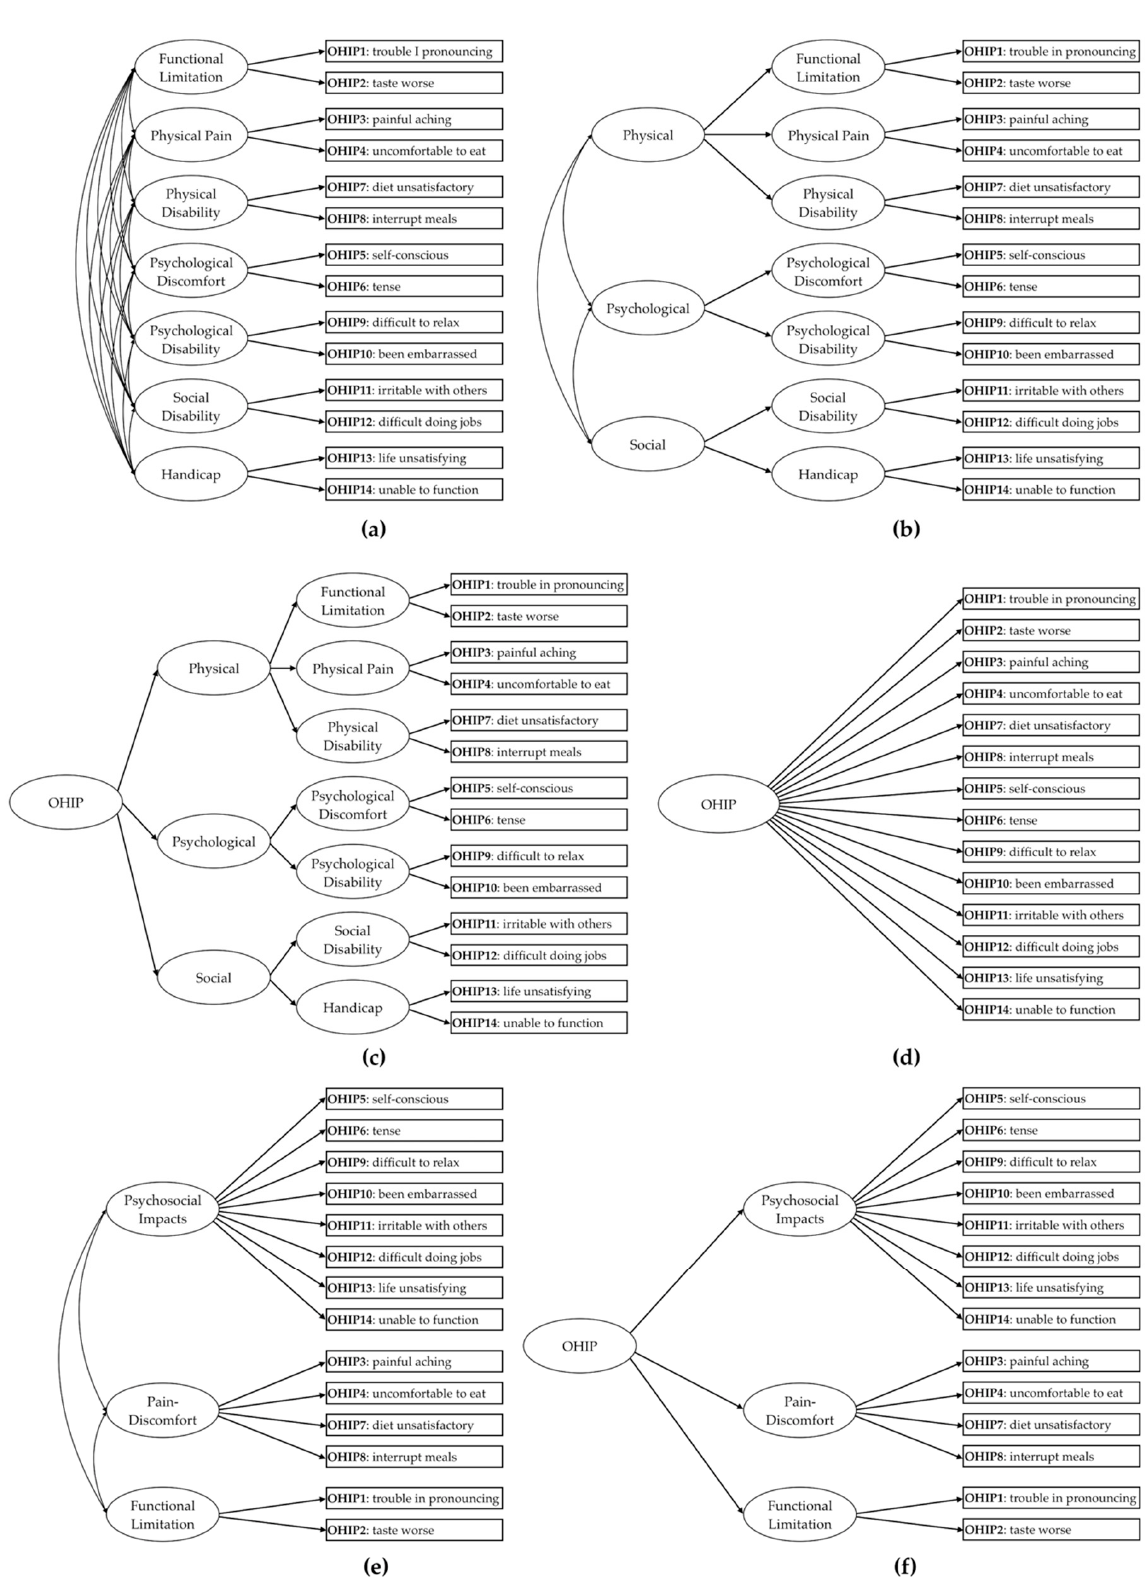
Figure 1. Factorial models of the Oral Health Impact Profile ‐ 14 (OHIP ‐ 14) tested in the study: ( a ) 7 first ‐ order factors; ( b ) and ( c ) second ‐ and third ‐ order hierarchical models with 7 first ‐ order factors; ( d ) unifactorial model; ( e ) trifactorial model; ( f ) second ‐ order hierarchical model with 3 first ‐ order factors.